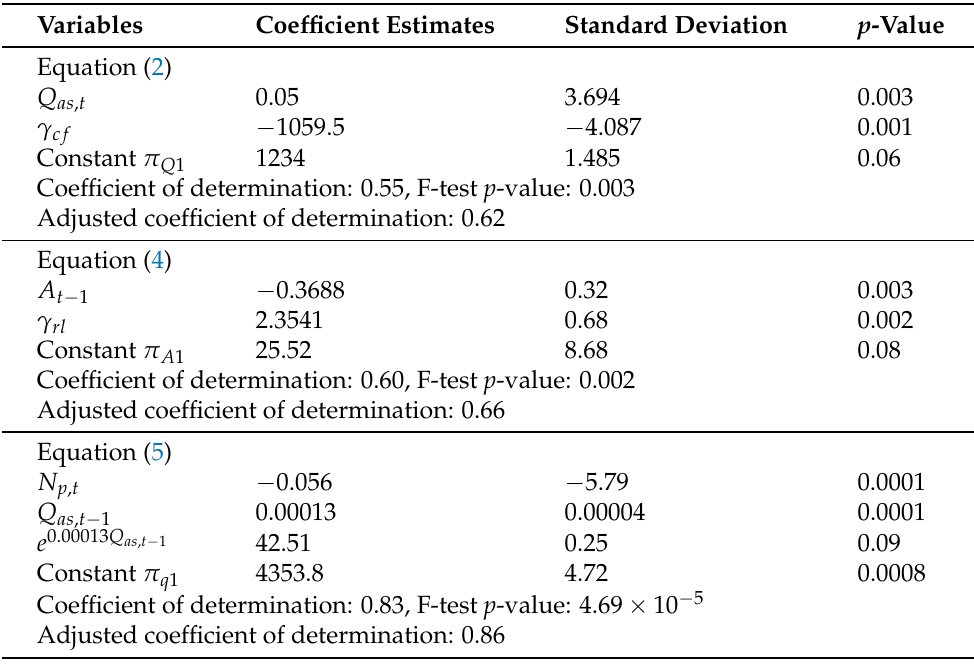
Table 4. The estimated parameters of the synthetic ammonia